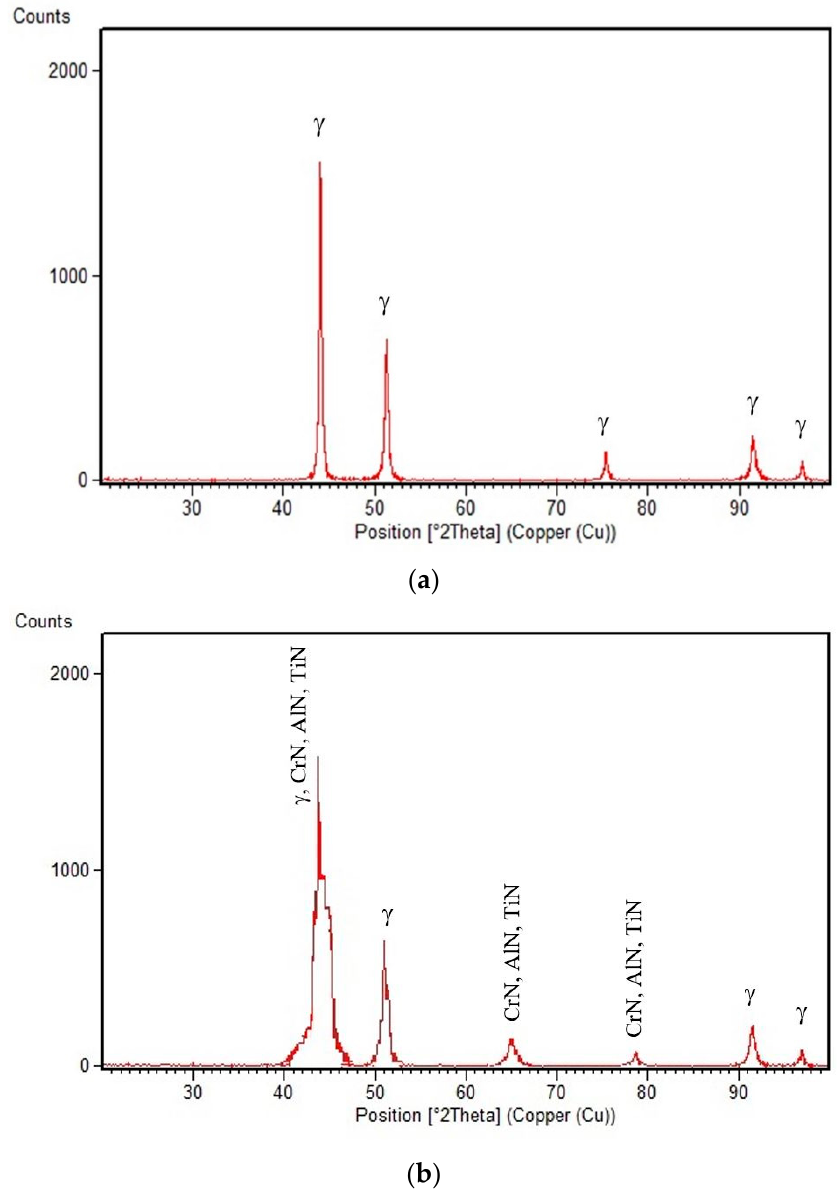
Figure 11. XRD patterns of the samples: ( a ) Reference material; ( b ) Nitrided material.